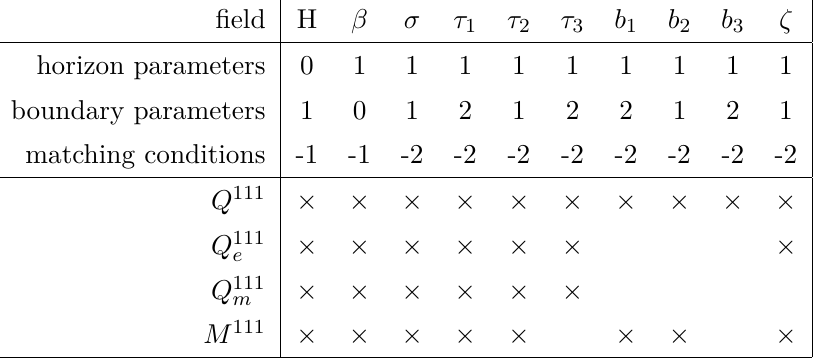
Table 1 . Overview of the degrees of freedom for the boundary value problem in each model. The horizon and boundary parameters are discussed in sections 3.2.3 and 3.2.2, respectively. The number of matching conditions for each field is given by the order of its equation of motion. This is usually referred to as the number of (dynamical) degrees of freedom, but they count negatively towards the number of free parameters of the boundary value